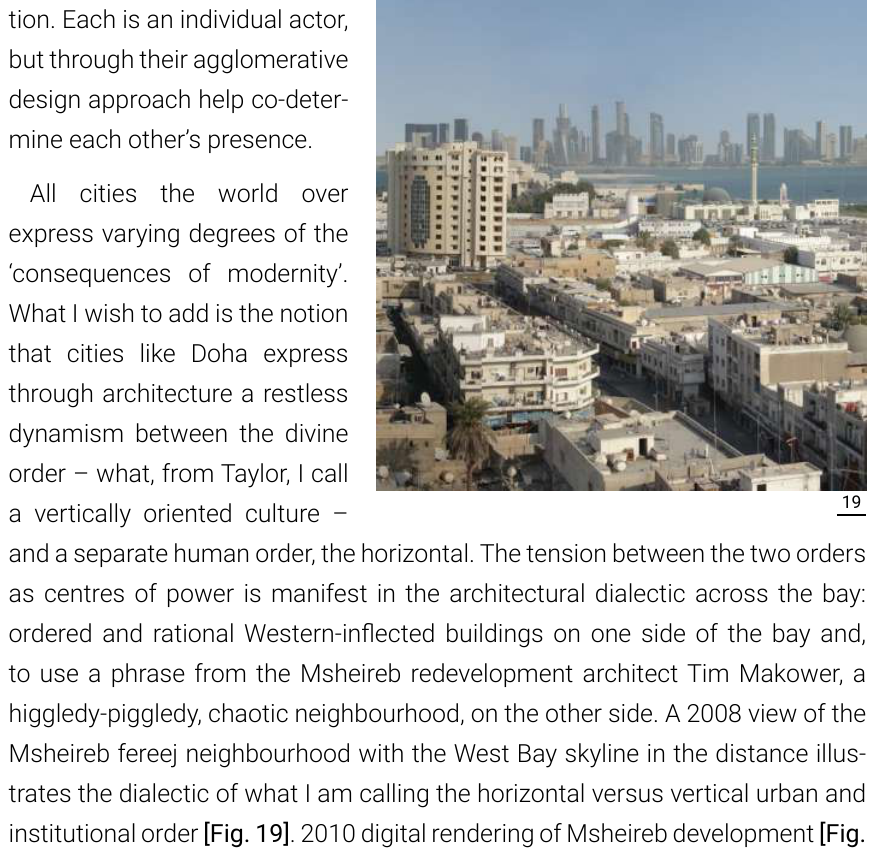
In the foreground, Msheireb fereej (Source: Peter Chomow - icz, 2009).